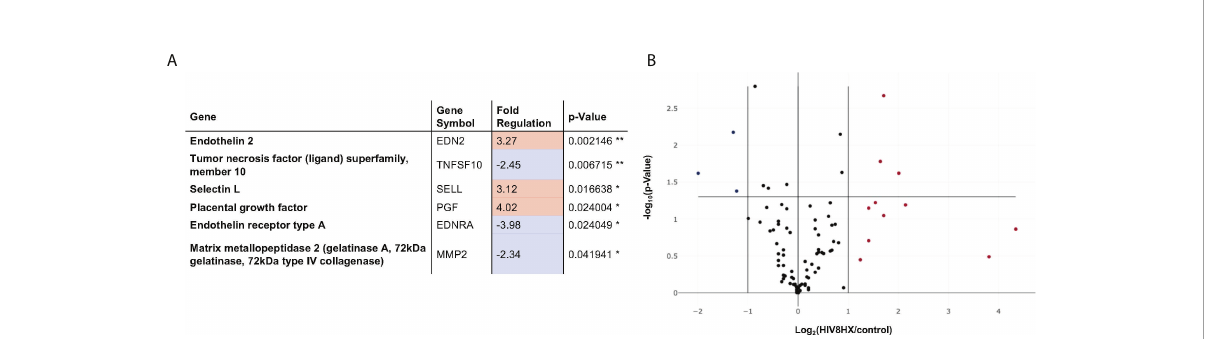
FIGURE 6 Changes in endothelial cell biology gene expression in HIV-infected hu-mice living under hypoxia, compared to hu-mice in normoxia. Gene expression in the lungs was analyzed using a PCR array targeted to 84 genes relevant in endothelial cell biology. All transcripts were detected using SYBR Green qPCR Mastermix (Qiagen, Inc). Changes in gene expression were determined using the 2 - DD Ct method in datasets generated from n=12 mice (4 males and 8 females). Panel (A) lists six out of 84 genes that had fold changes > 2. The p values are calculated based on a Student ’ s t-test of the replicate 2^(- Delta CT) values for each gene in the control group and treatment groups, and p values less than 0.05 are indicated with a *, p values less than 0.01 are indicated with **. The p-value calculation used is based on parametric, unpaired, two-sample equal variance, two-tailed distribution. Panel (B) shows a Volcano Plot that indicates the level of signi fi cance of gene expression relative to the whole 84-gene PCR array.